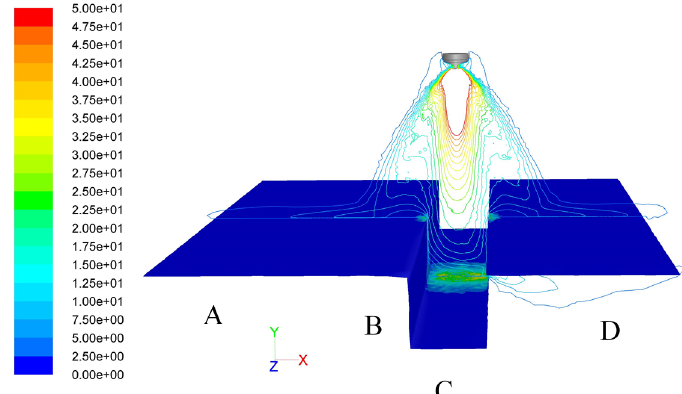
Figure 9. Calculated velocity contours colored by velocity magnitude (m/s) in the plane z = 0 (shaping air flow rate: 150 L/min). The static film thickness distribution on the plates is also overlaid.